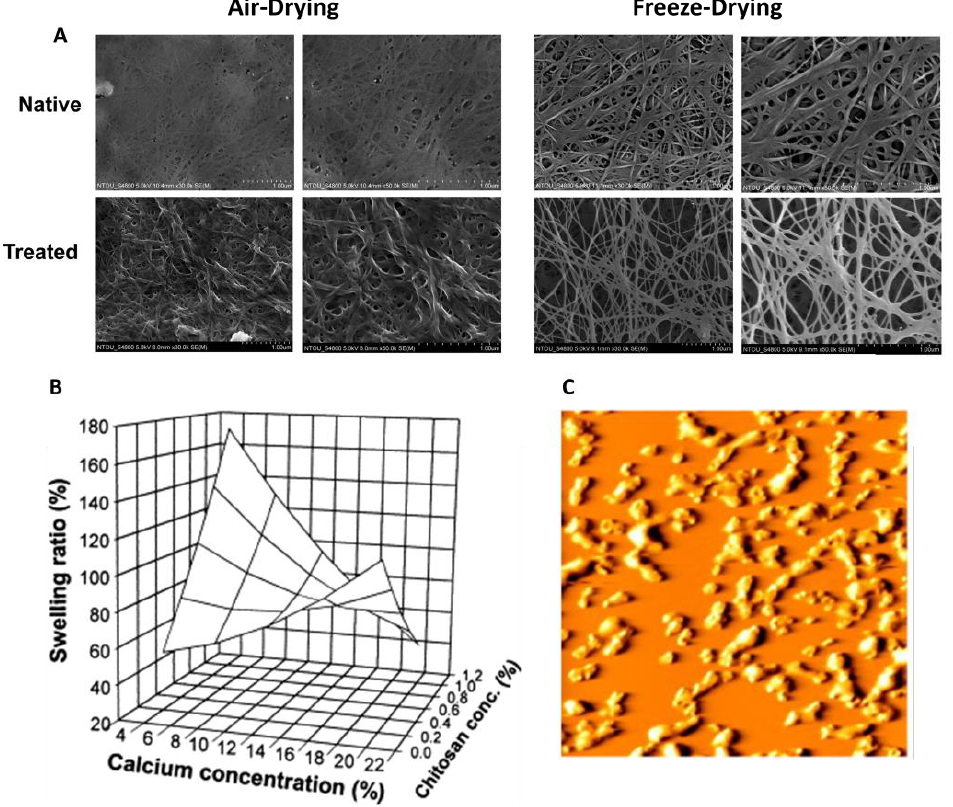
Figure 9. Novel applications of protein – polysaccharide composite materials: A ) SEM images of the silymarin – zein nanoparticle/bacterial cellulose nanofibers used in a wound dressing application; B ) silymarin–zein nanoparticle / bacterial cellulose nanofibers used in a wound dressing application; B ) Swelling ratio and release of protein from chitosan – pectin particles with change of the Ca 2+ Swellingratioandreleaseofproteinfromchitosan–pectinparticleswithchangeoftheCa 2 + concentration in acidic solution; C ) AFM 3 × 3 µ m image of protein–polysaccharide ( β -lactoglobulin with